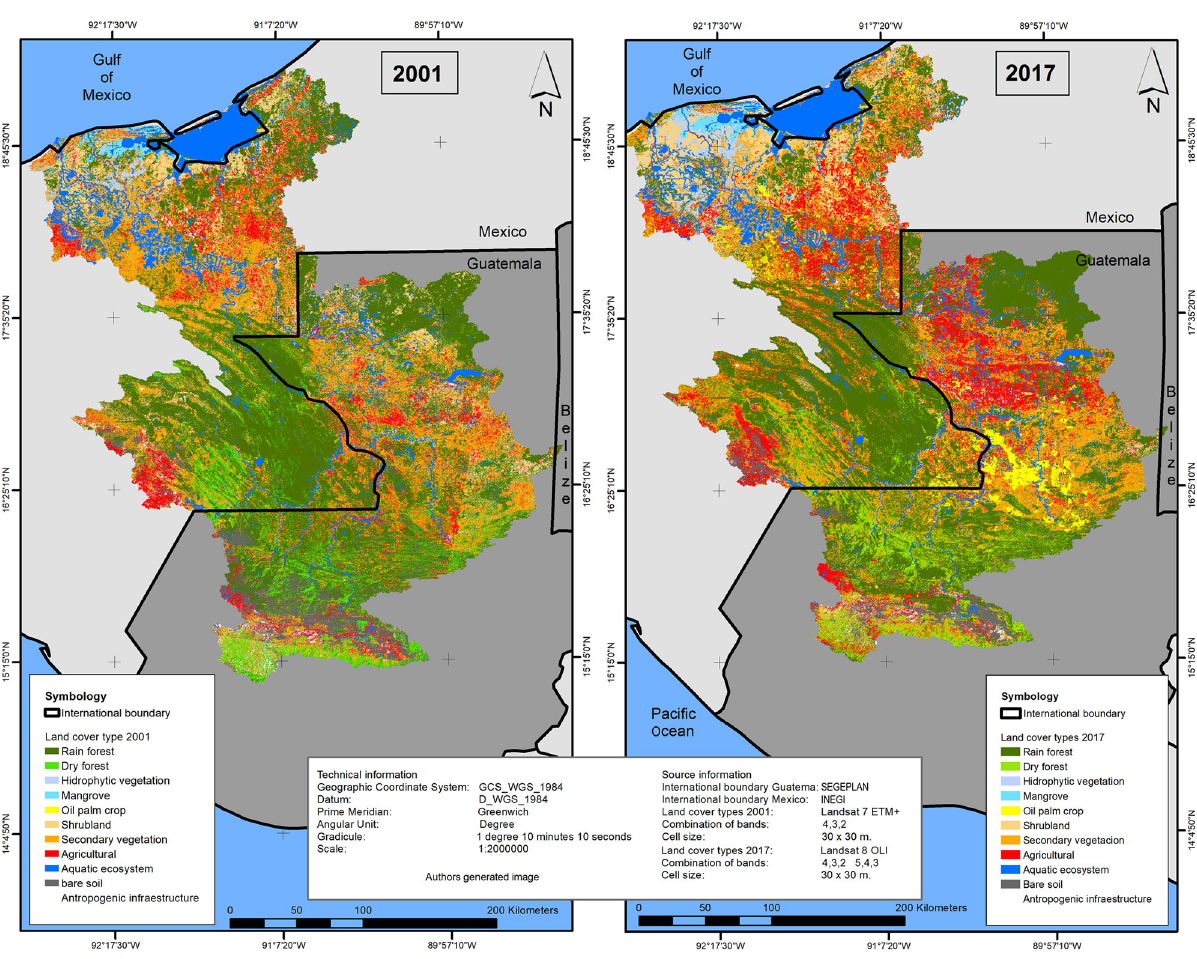
Fig 2. Land use/land cover changes (2001–2017) generated with the GIS software ESRI ArcGIS 10.5. Copyright © 1995–2022 Esri. All rights reserved. Published in the United States of America. (Data source: Landsat 7 ETM+ and Landsat-8 OLI image courtesy of the U.S. Geological Survey).